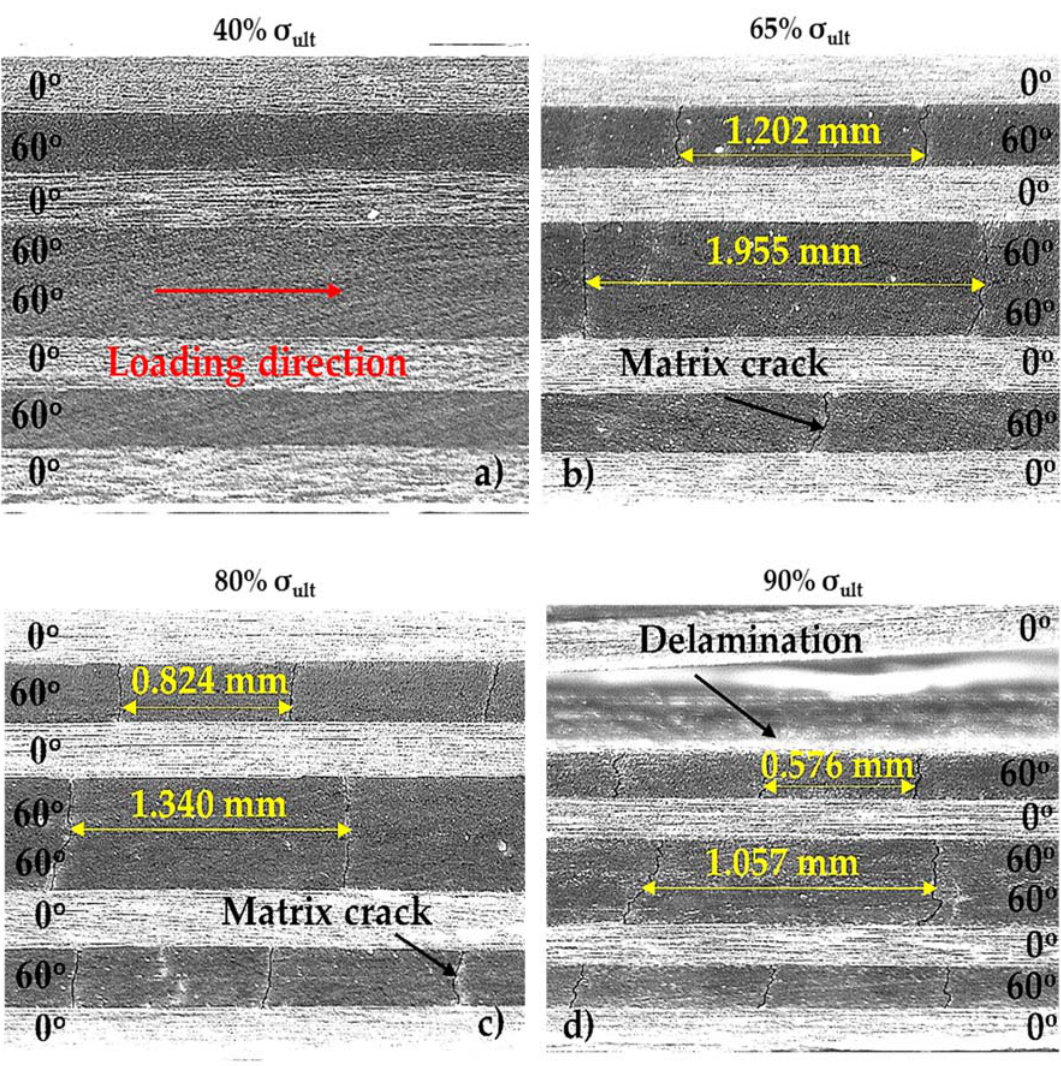
Figure 5. Damage state of [0°/60°] 2s laminates at ( a ) 40%, ( b ) 65%, ( c ) 80%, and ( d ) 90% of σ ult